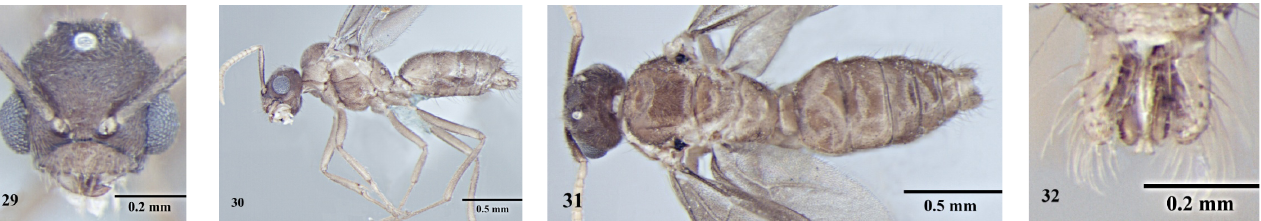
Fig. 29-32. Pseudolasius polymorphicus sp. n ., male 29) head, full face view; 30) body, lateral view; 31) body, dorsal view; 32) genetalia, dorsal view.